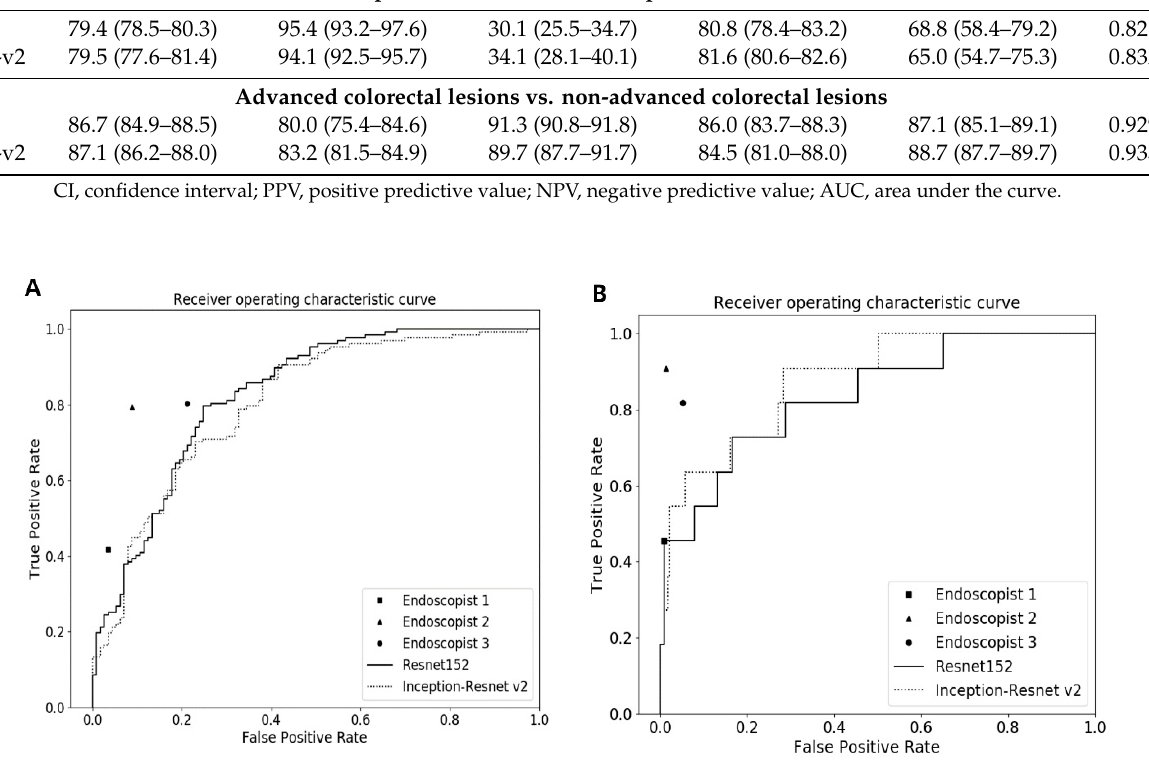
Figure 4. Receiver operating characteristic curves for binary classification of ( A ) colorectal neoplasms (TA or higher) and ( B ) advanced colorectal lesions (HGD or higher) in the external validation dataset. TA, tubular adenoma; HGD, high-grade dysplasia.